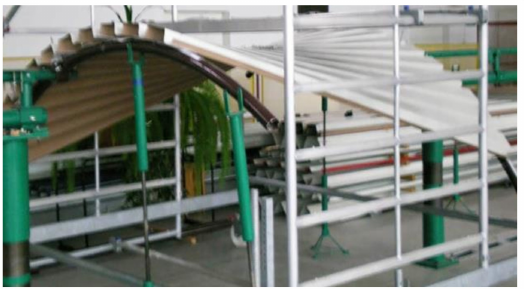
Figure 1. Experimental folded shell sheeting supported by two curvilinear skew